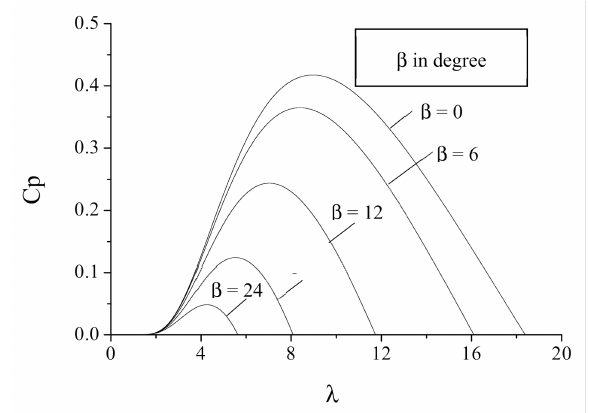
Figure 5. Power coe ffi cient ( Cp– λ ) curves for several values of pitch